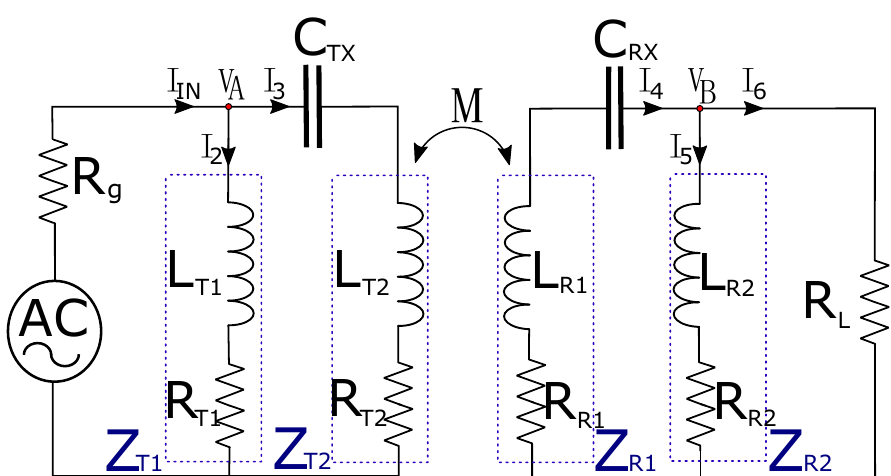
Figure 3. The circuit diagram of the proposed two-loop resonant WPT system with additional inductor. I IN , I 2 , I 3 , I 4 , I 5 and I 6 represent the currents in each branch, while the Z T 1 , Z T 2 , Z R and Z R 2 represent impedance of the